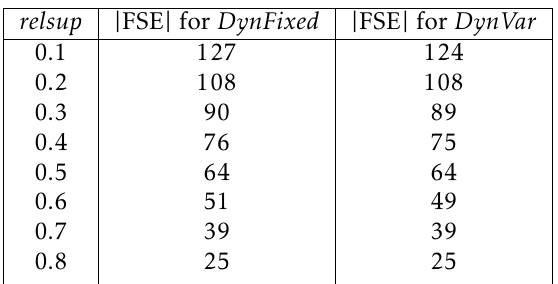
Table 12. Execution time (in milliseconds ) to find frequent singleton edges for graph stream data using proposed static approach with actual minimum support through linear strategy in sequential and parallel environment